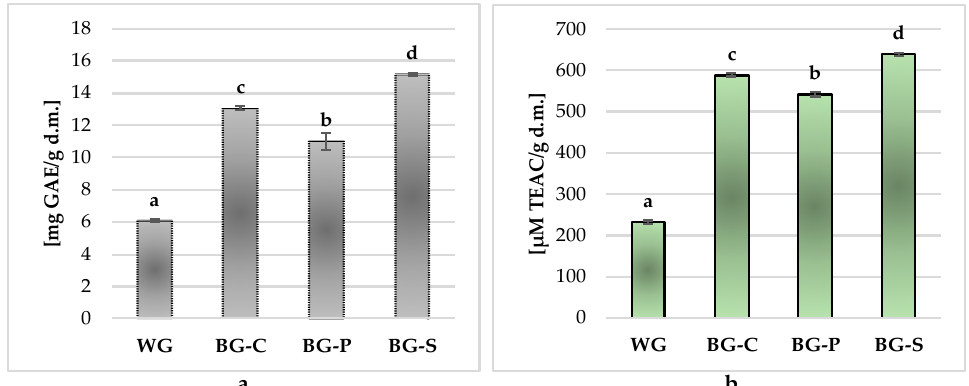
Figure 3. Total polyphenols content ( a ) and antioxidant activity ( b ) in white garlic and black garlic products. Values are means ± standard deviation ( n = 6). Different letters in bars (a–d) are significantly different ( p < 0.05). WG—white garlic; BG-C—black garlic cloves; BG-P—black garlic powder; BG-S—black garlic spread.